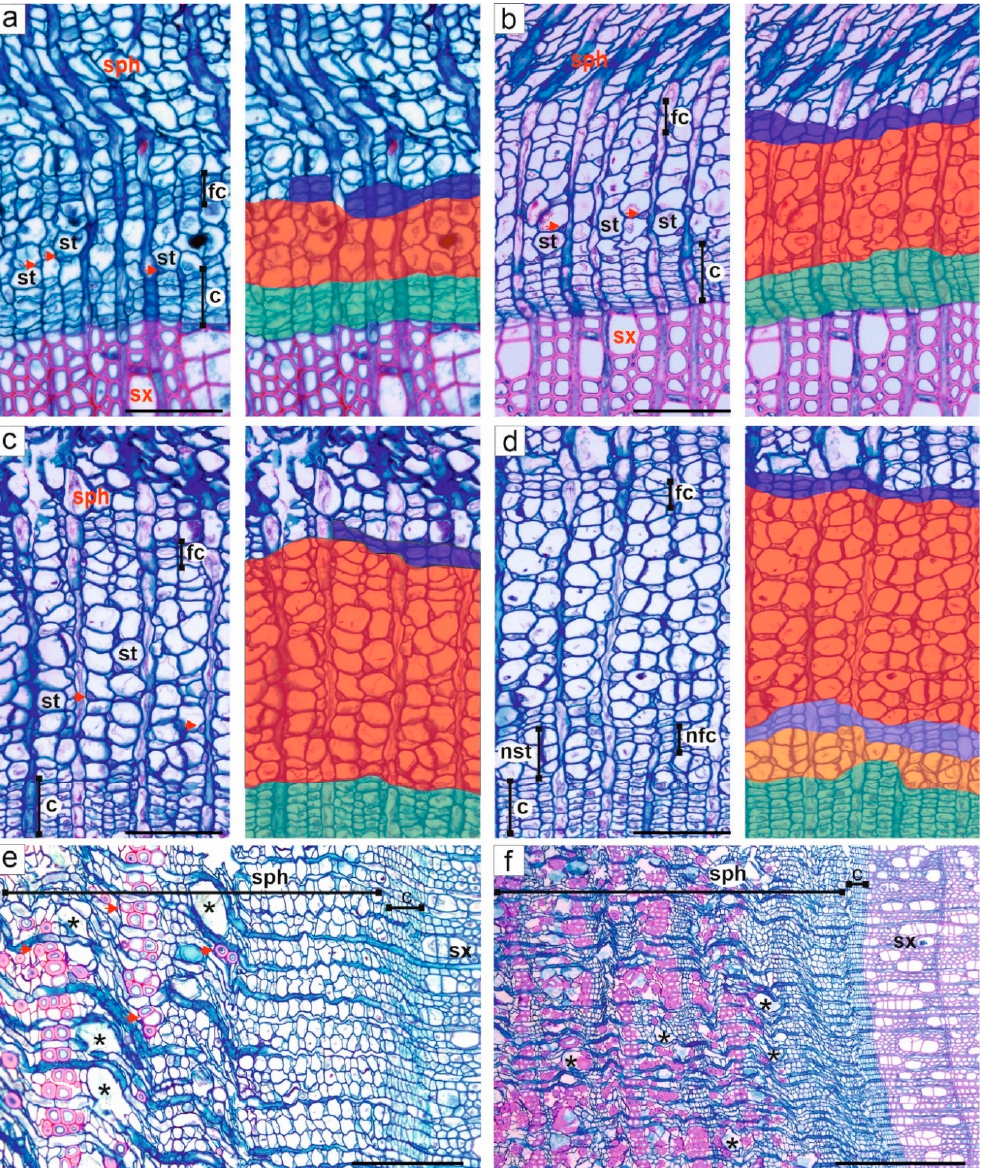
Figure 6. Intra-annual changes in secondary phloem differentiation presented on transverse sections of Aesculus hippocastanum. ( a – d ) successive stages of secondary phloem development (left panels) and interpretation of the stages (right panels); ( a ) 5 April (95 DOY; day of the year); HIT, in the neighbourhood of dormant cambium (c, filled with green); sieve tubes (st, filled with red) with characteristic companion cells (arrows), which were formed in the previous year, are clearly visible; the flattened cells (fc, filled with blue) are located 3–4 cells from the cambium; ( b ) 19 April (109 DOY); LIT, as the result of the onset of cambium activity (c, filled with green) new sieve tubes (st) are formed (the region of conductive cells filled with red) thus the flattened cells (fc, filled with blue) are moved away from the cambium; at this time, no secondary xylem cells have been formed; ( c ) 21 June (172 DOY); LIT, further formation of secondary phloem cells (the region of conductive cells filled with red) resulted in flattened cells (fc, filled with blue) moving away; ( d ) 19 July (200 DOY); LIT, formation of new flattened cells (nfc, filled with light blue) in current year; flattened cells (fc) originated in previous year are filled with blue; near the cambium (c, filled with green) new sieve tubes (nst, filled with light red) originated; ( e – f ) mature secondary phloem; in non-conducting secondary phloem sieve tubes are modified into fibres (arrows), whereas some parenchyma cells have enlarged significantly (asterix). Each photo is taken from the most explanatory sample of LIT or HIT. Bars: ( a – d ) 100 µ m; ( e ) 200 µ m; ( f ) 500 µ